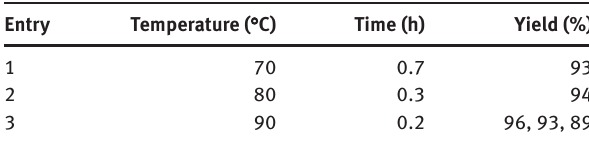
Table 2: Different reaction temperatures and the reusability of